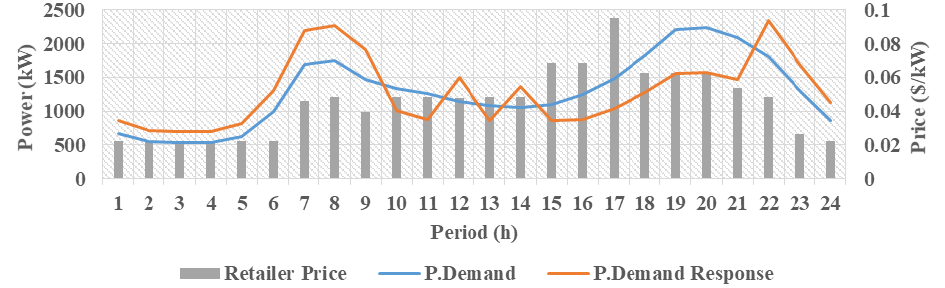
Figure 6. The demand response behavior of prosumer to the retailer pricing in a 30% demand